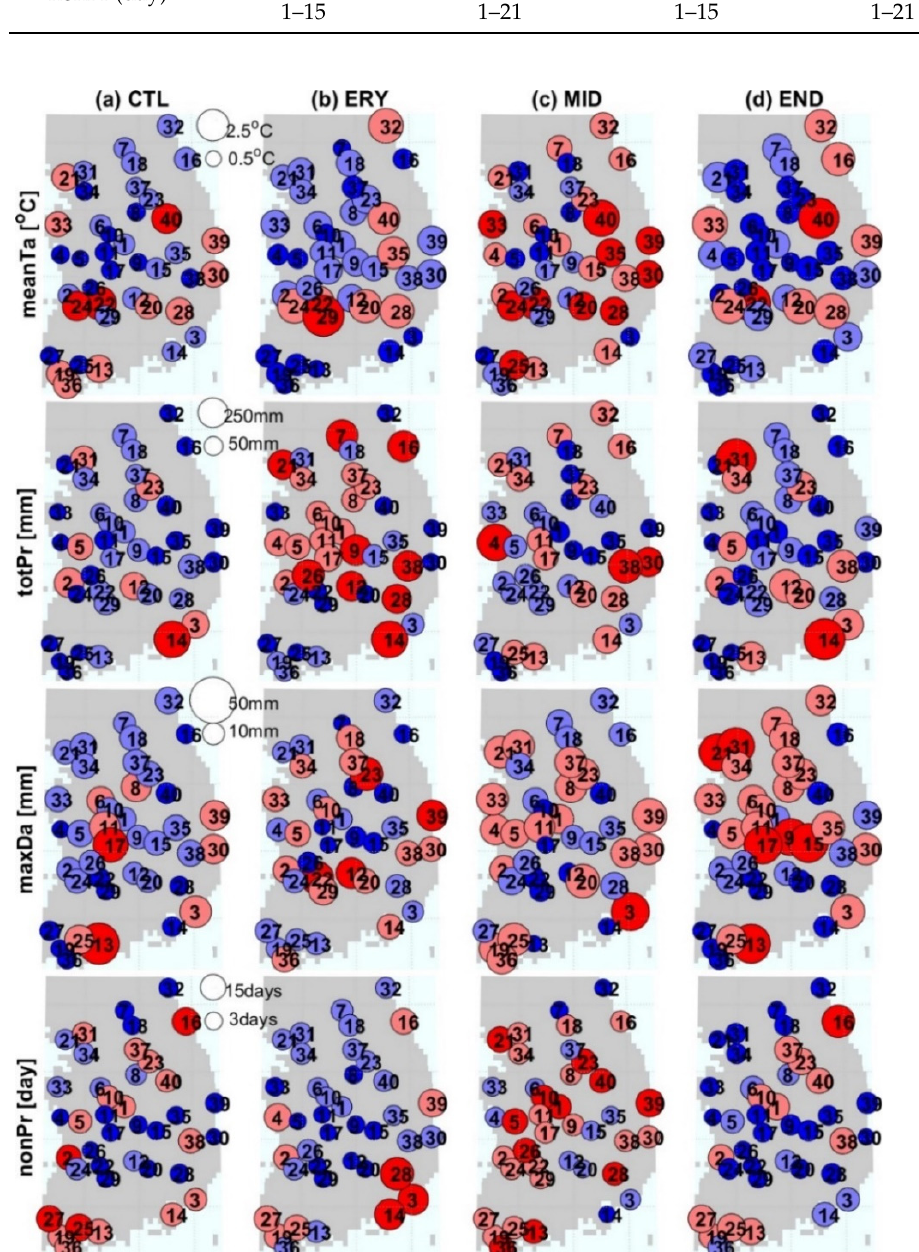
Figure 6. Spatial distributions of the UGCM values over South Korea in the ( a ) CTL, ( b ) ERY, ( c ) MID, and ( d ) END periods for the SSP5-8.5 for 4 indices, computed for the whole year. In total, 40 locations were classified into 4 clusters (from the smallest cluster (dark, blue-colored circles) to the largest cluster (red colored circles)) by applying the K-means algorithm.